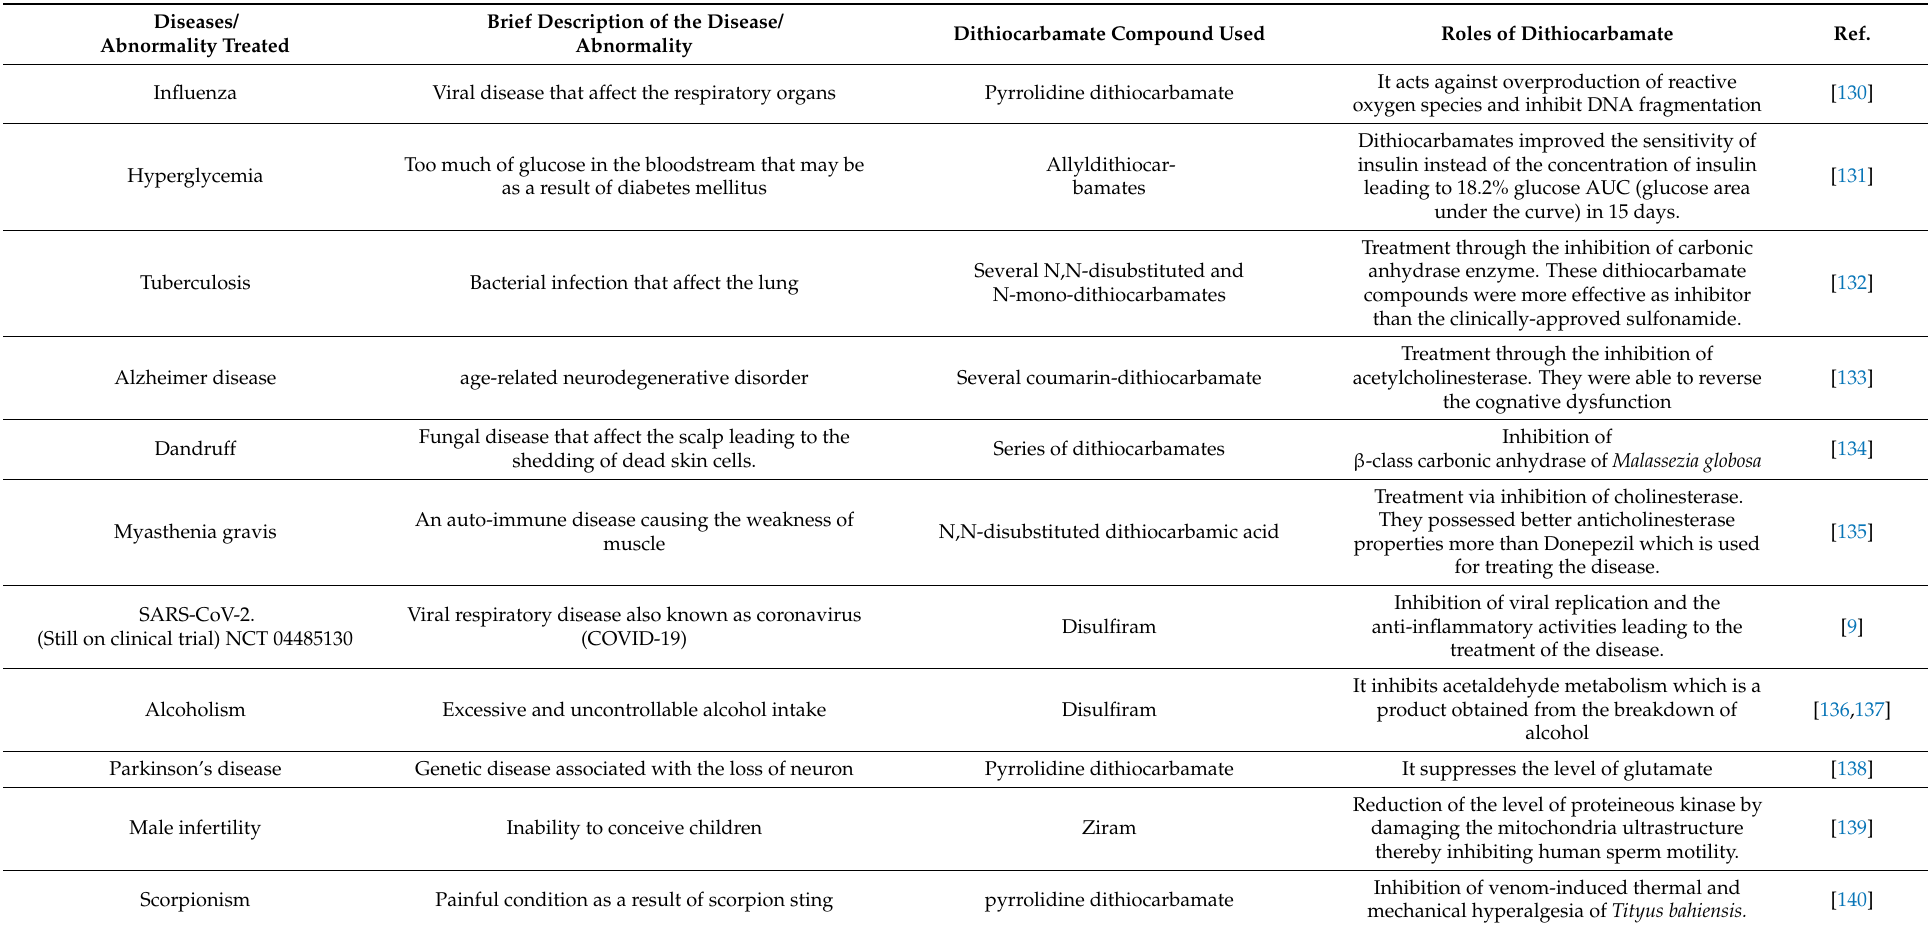
Table 5. Different diseases treated with dithiocarbamate